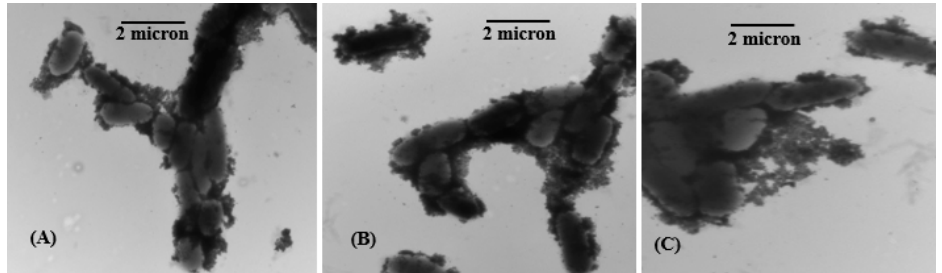
Figure 12. Representative TEM images of ( A ) E. coli ( B ) P. aeruginosa ( C ) S. enterica after treatment with prismatic silver nanoparticles coated with poly-Arg-PVP.